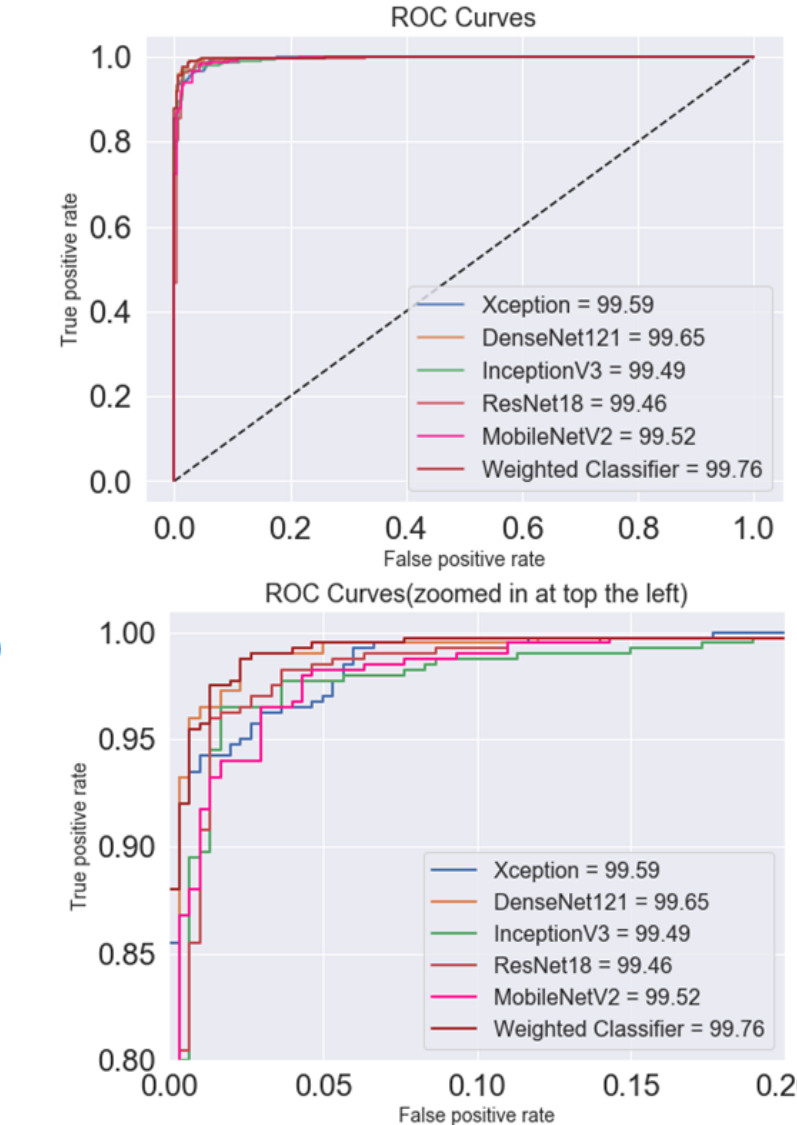
Figure 10. Comparison between ( a ) the AUC (area under the curve) and ( b ) ROC (receiver operating characteristics) curves for different architectures and the weighted classifier for the testing dataset. The weighted classifier (brown line), followed by DenseNet121 (yellow line), had the highest